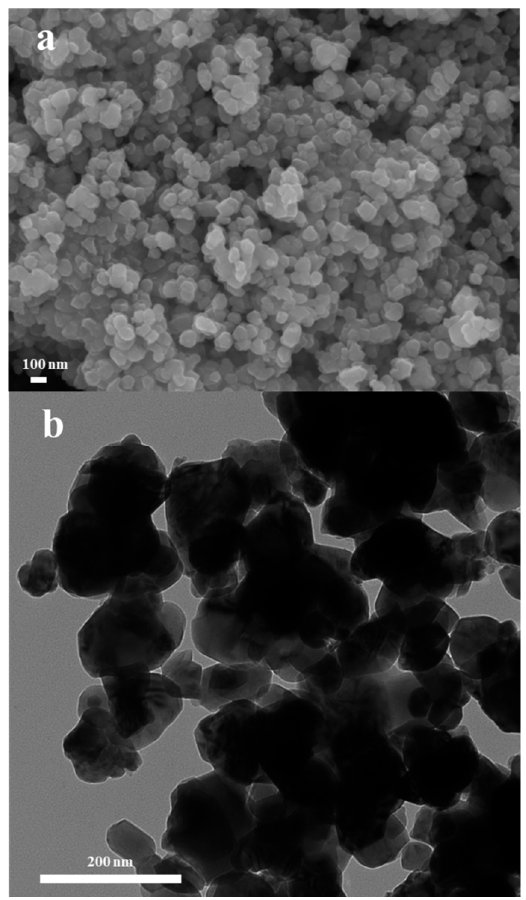
Figure 1. ( a ) SEM and ( b ) TEM micrographs of LCF sample.